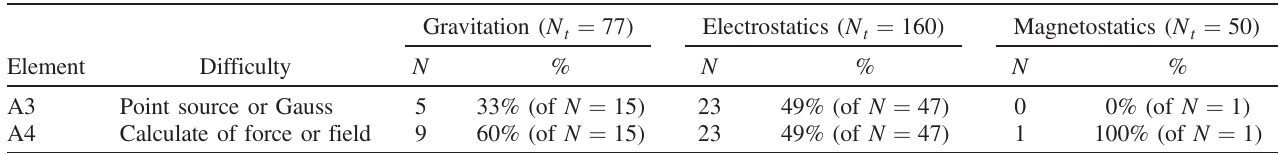
TABLE I. Difficulties activating direct integration via Eqs. (1) – (3) as the appropriate mathematical tool for exam questions featuring a rod or strip distribution (e.g., Fig. 1). Each N column gives the number of students who were coded as having an error with each of the given elements of the framework. This is also given as a percentage of the overall students who were coded as having difficulty with the activation component in the % column ( N given in parentheses). For completeness, N included at least one element of activation. Codes are not exhaustive or exclusive (so percents may not total to 100%) but represent the most common